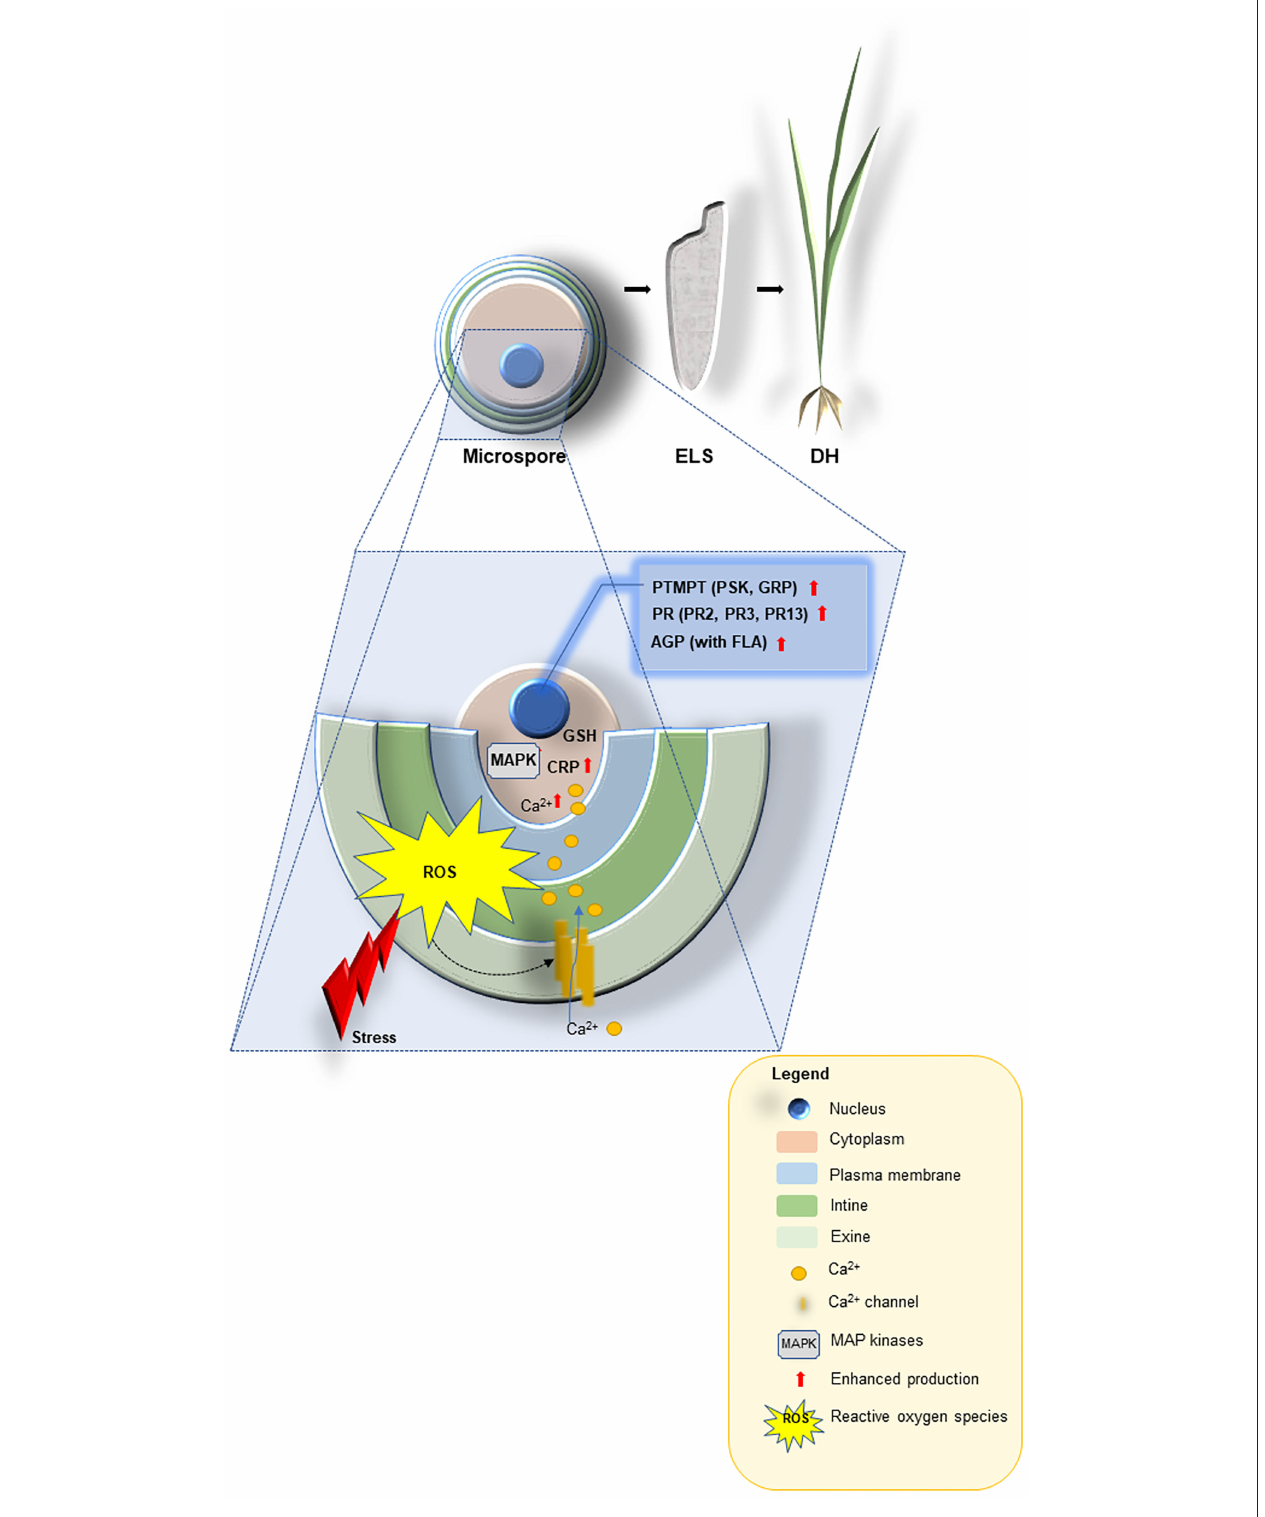
FIGURE 1 | A schematic model describing the proposed functions for stress-related proteins, cysteine-rich tripeptide glutathione, other cysteine-rich and the small post-translationally modified peptides (PTMPs) in microspore embryogenesis signaling and their use as promising tools for improving doubled-haploid (DH) production